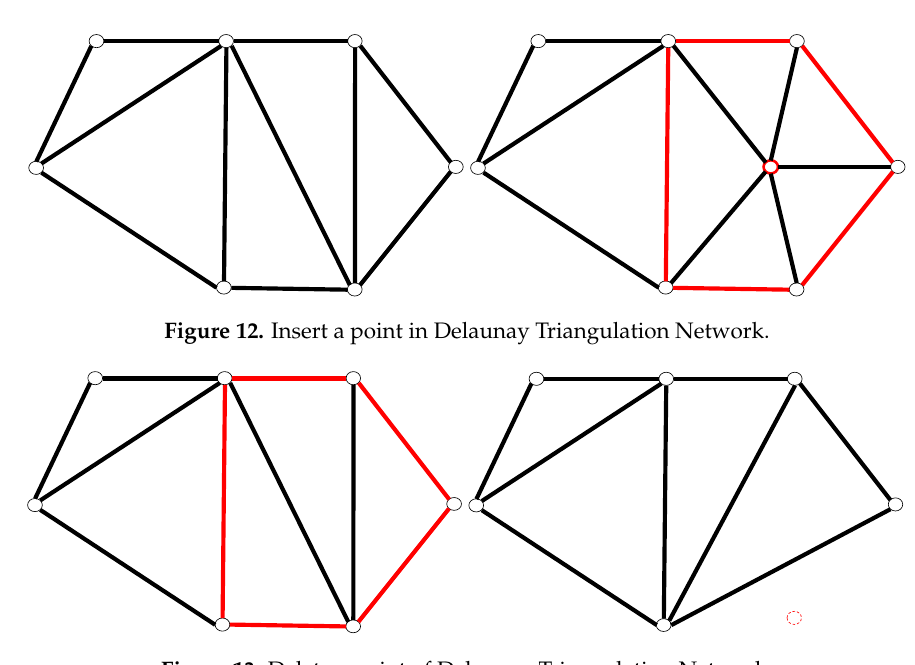
Figure 13. Delete a point of Delaunay Triangulation Network.